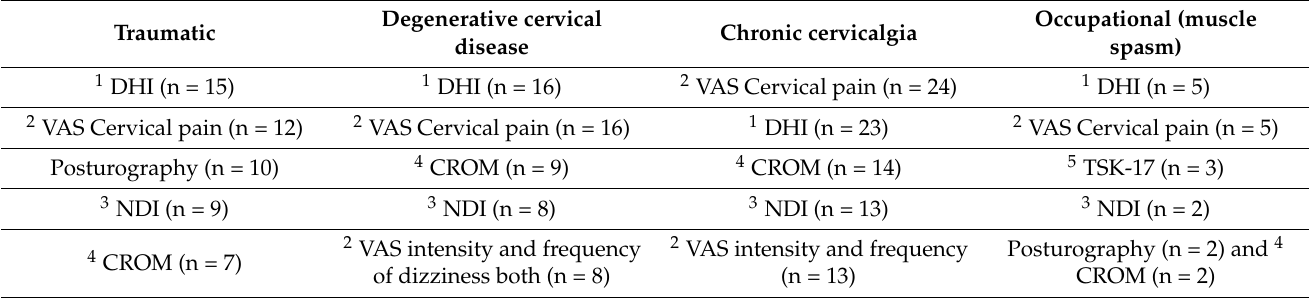
Figure 9. Measurement instruments in proprioceptive cervicogenic dizziness: an ICF classification (some measurement instruments are suitable in more than one ICF component). CROM: cervical range of motion, DHI: dizziness handicap inventory, GPE: global perceived effect, GROC-scale: global rating of change, HADS: Hospital Anxiety and Depression Scale, JPE: joint position error test, NDI: neck disability index, HRQoL: health-related quality of life, TSK: Tampa Scale for Kinesiophobia, VAS: visual analog scale.